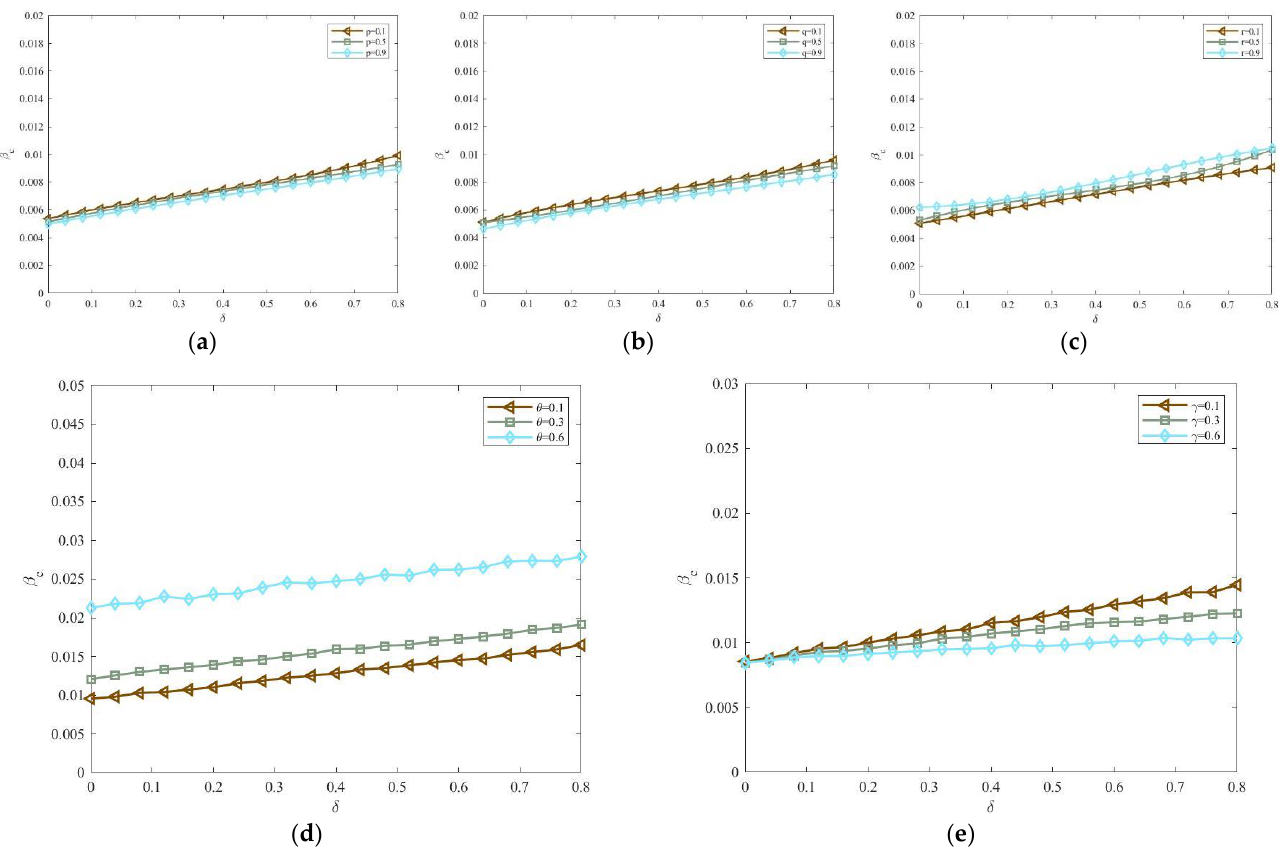
 . The parameters are c